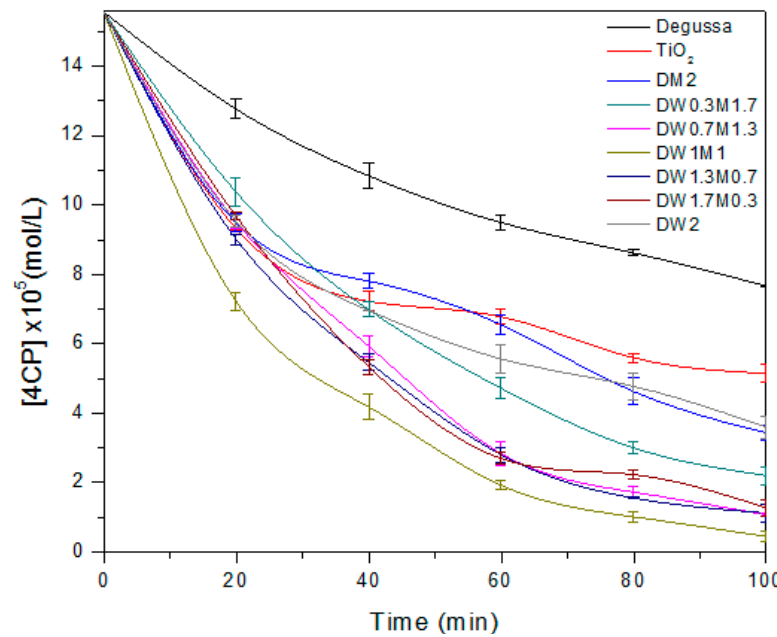
Figure 12. 4-Chlorophenol photodegradation profiles over TiO 2 , Mo-TiO 2 , W-TiO 2 , W-Mo-TiO 2 , and